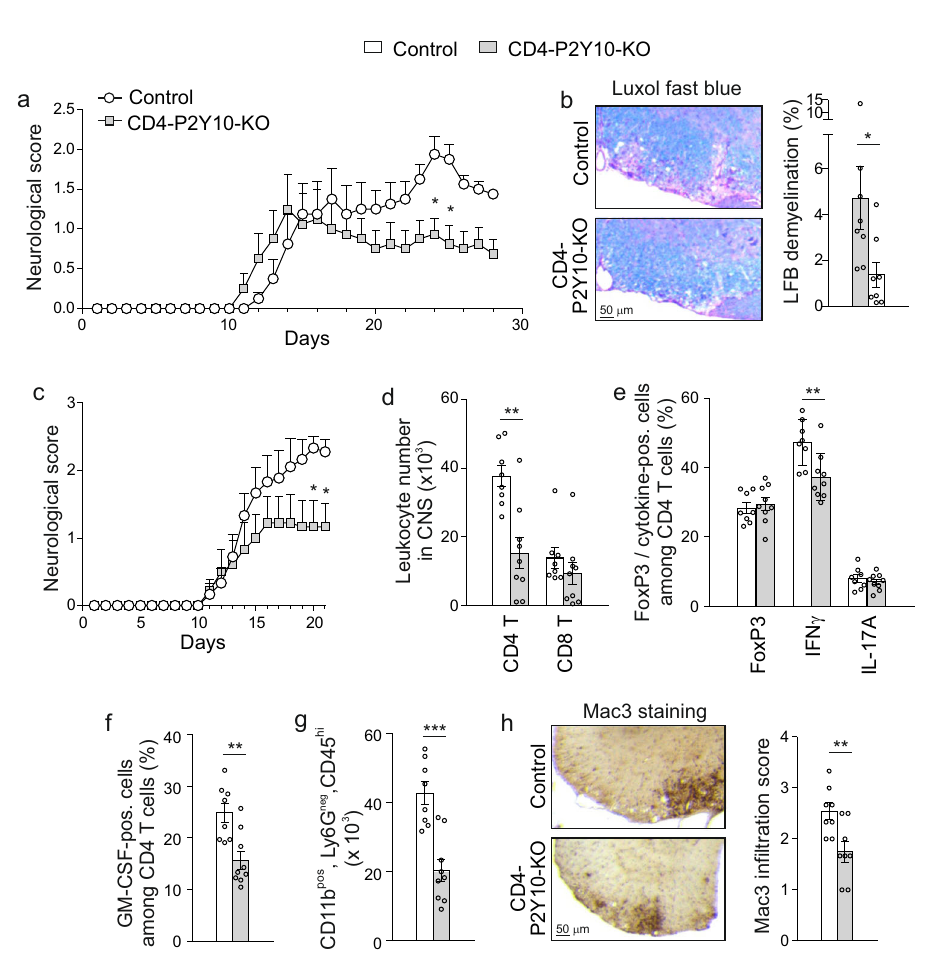
Fig. 2 Reduced neuroin fl ammation in CD4-P2Y10-KOs. a Neurological score ( n = 8; * p = 0.037 (d24), 0.0189 (d25)). b Quanti fi cation of demyelination by luxol fast blue (LFB) staining on day 28 after induction of EAE: Exemplary photomicrographs (left) and statistical evaluation (right) ( n = 8; * p = 0.039). Repetition of EAE in an independent cohort ( n = 8 – 9): Neurological score ( c ; * p = 0.019 (d20), 0.033 (d21)) and fl ow cytometric analysis of spinal cord-in fi ltrating leukocytes on day 20 ( d – g ): Absolute numbers of CNS-in fi ltrating T cells ( d ; ** p = 0.001), proportion of FoxP3, IFN γ -, IL-17A- ( e ; ** p = 0.008) or GMCSF- ( f ; ** p = 0.003) expressing cells among in fi ltrating CD4 cells, absolute numbers of CD11b + ,CD45 hi macrophages ( g ; *** p <0.001). h Quanti fi cation of Mac3- positive cells in lumbar CNS: Exemplary photomicrographs (left) and statistical evaluation (right) ( n = 8; ** p = 0.009) (same mice as in a , b ). Data are means±SEM; comparisons between genotypes were performed using two-tailed unpaired Student ’ s t- test ( b , d – h ) or two-way ANOVA with Tukey ’ s multiple comparisons test ( a , c ). n , number of mice per group.